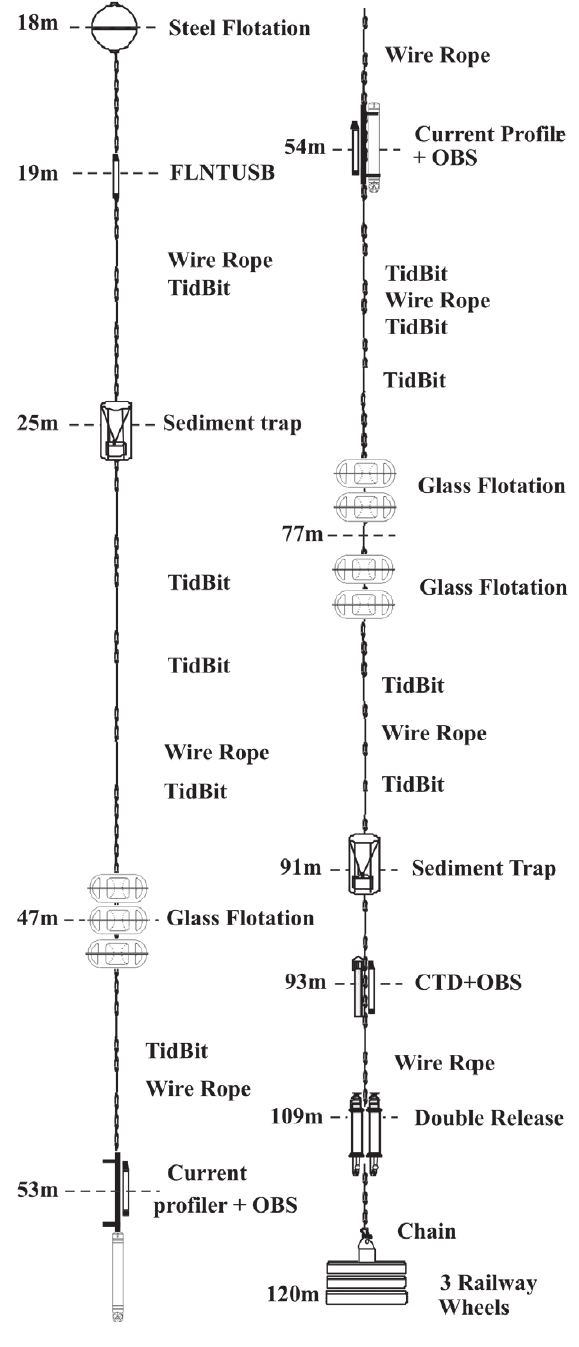
Figure 2 - The Cabo Frio subsurface mooring array layout intended to deploy at a depth of 120